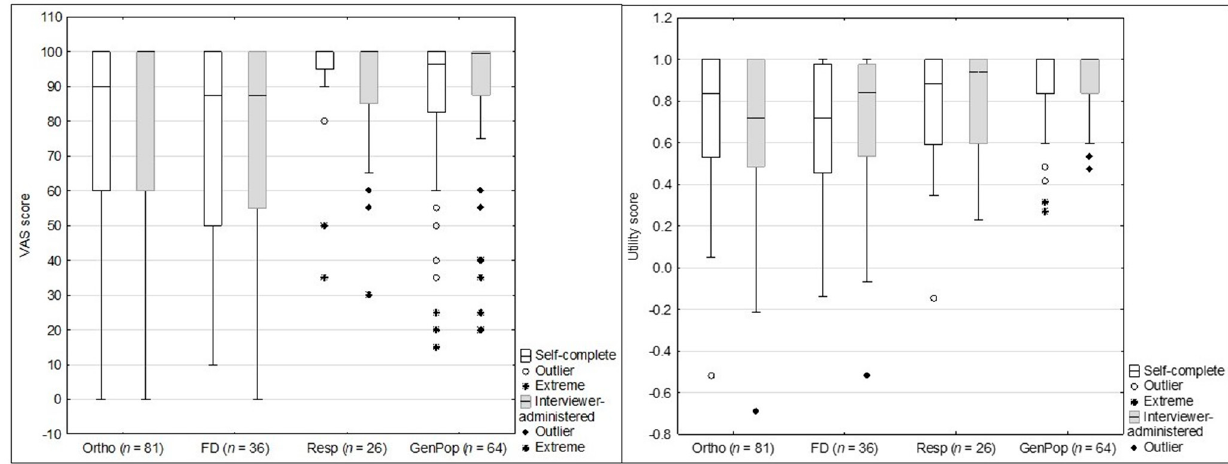
Figure 2. VAS and utility scores for the self-complete and interviewer-administered versions across known health groups. Boxes indicate first (25th) to third (75th) quartiles, the dividing line indicates the median, whiskers indicate the remaining points up to the length of 1.5 times the interquartile range and markers indicate any remaining outliers.